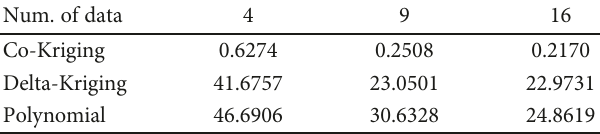
Table 2: Maximum relative error. Num. of